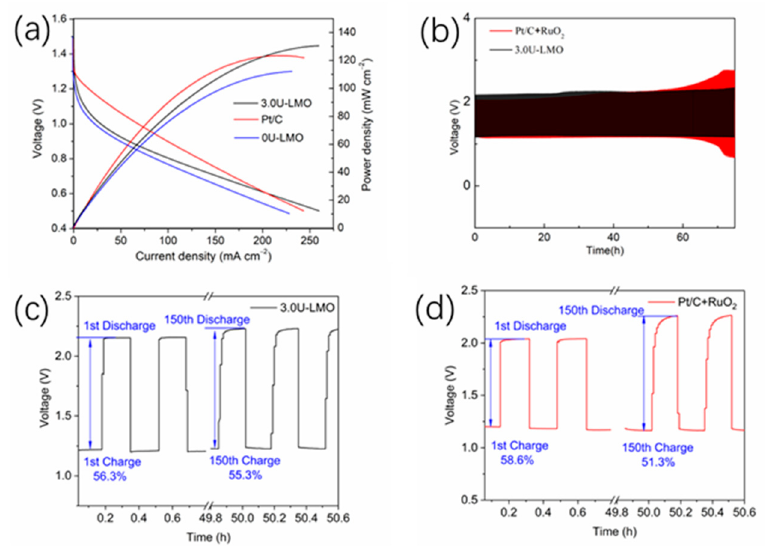
Figure 7. ( a ) OER properties over xU-LMO (x = 0, 1.5, 3.0, and 4.5) catalysts in 0.1 M KOH solution and ( b ) the potential difference ( Δ E) between E j = 1 mA cm − 2 (OER) and E 1/2 (ORR) of xU-LMO (x = 0, 1.5, 3.0, and 4.5) catalysts.